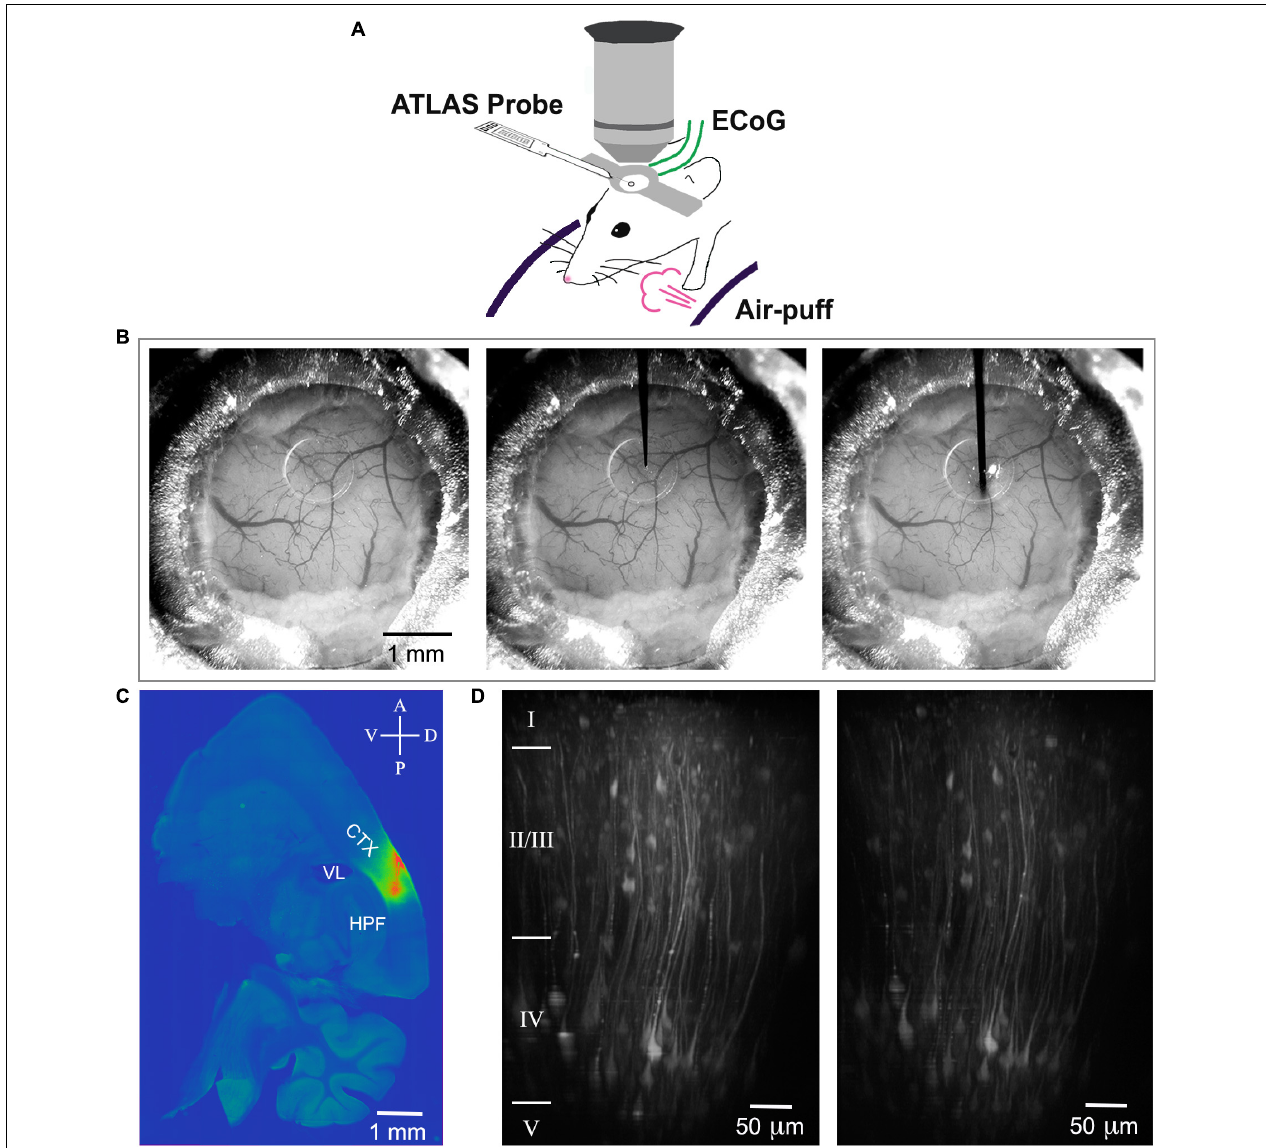
FIGURE 1 | Scheme of the experimental setup, probe insertion and reconstruction of the insertion track. (A) A mouse is head-fixed on a cylindrical treadmill. An electrical probe (Atlas Neuroengineering) is inserted through the access port of the chronic cranial window into the brain and allows electrical recording. The window allows two-photon imaging of voltage or calcium depth resolved. For sensory stimulation, air puffs can be applied. (B) Mouse cranial window before probe insertion (left), with the tip of the probe positioned on the surface of the silicon plug (center), and with the probe inserted 850 µ m deep into cortex (right). (C) ANNINE-6plus fluorescence in a 100- µ m thick sagittal brain slice (LM ≈ 2.3 mm). The pipette for loading ANNINE-6plus and the electrical probe are entering through the same port under the same angle. Therefore, the track of the probe insertion is very well approximated by the track of ANNINE-6plus labeling. CTX: cortex, somatosensory areas; VL: lateral ventricle; HPF: hippocampal formation (D) Two-photon reconstruction of cortical neurons expressing GCaMP6f before (left) and after (right) probe insertion with tip below imaging site. Imaging was done at the center of the craniotomy, right below the access port (AP 1.5 mm; LM 2.5 mm). Cortical layers